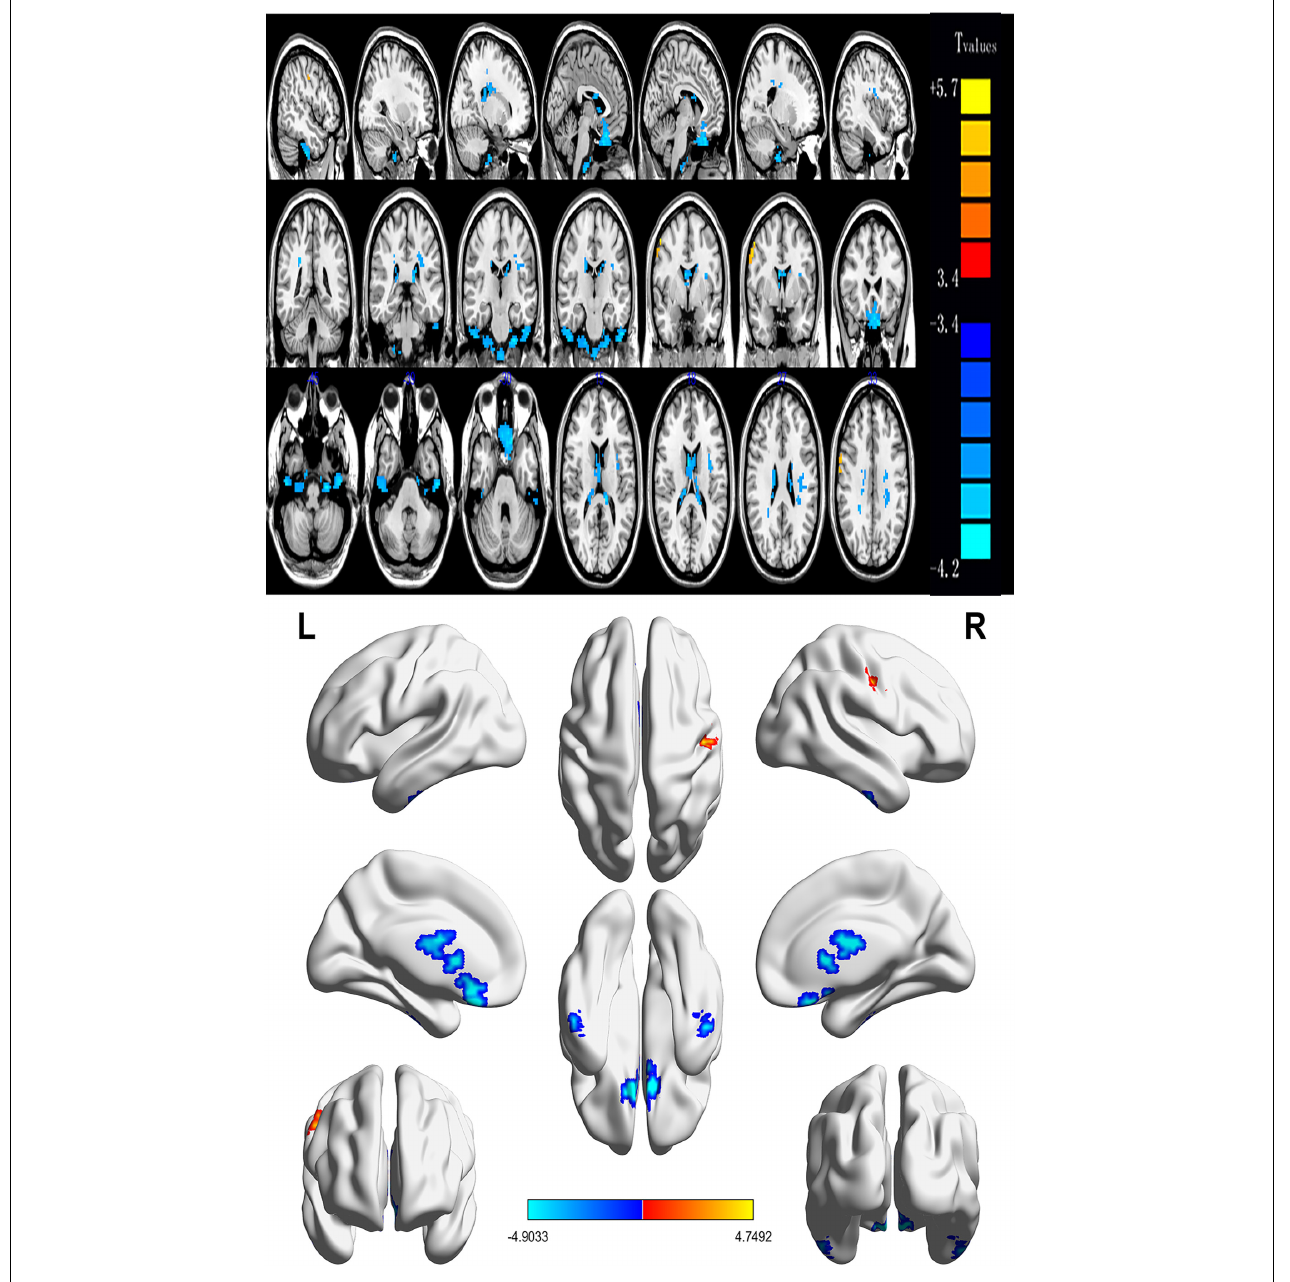
FIGURE 2 | Spontaneous brain activity in patients with severe obesity and meibomian gland dysfunction. Red regions (left cerebellum, right fusiform gyrus, left inferior temporal gyrus, left rectus gyrus, right thalamus, right caudate, left insula, and left thalamus) indicate higher ReHo values, while blue regions (right middle frontal gyrus) represent lower ReHo values ( P < 0.05; AlphaSim-corrected; cluster size, > 40). ReHo, regional homogeneity; R, right; L,